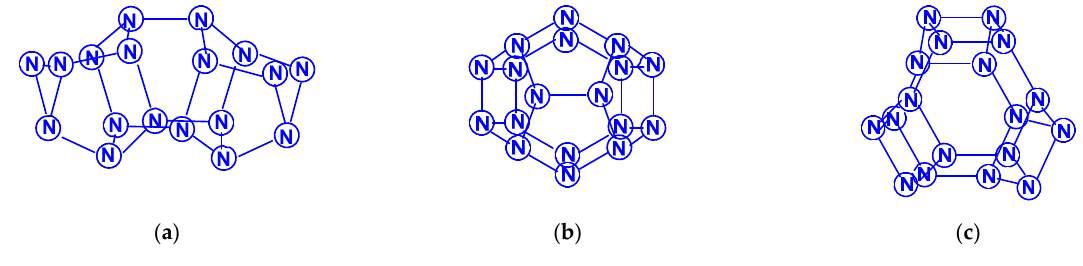
Scheme 14. ( a ): N 14 ( C 2 ); ( b ): N 14 ( C 2v ); ( c ): N 16 ( C 2 ); ( d ): N 16 ( D 4h ); ( e ): N 16 ( D 2h ).